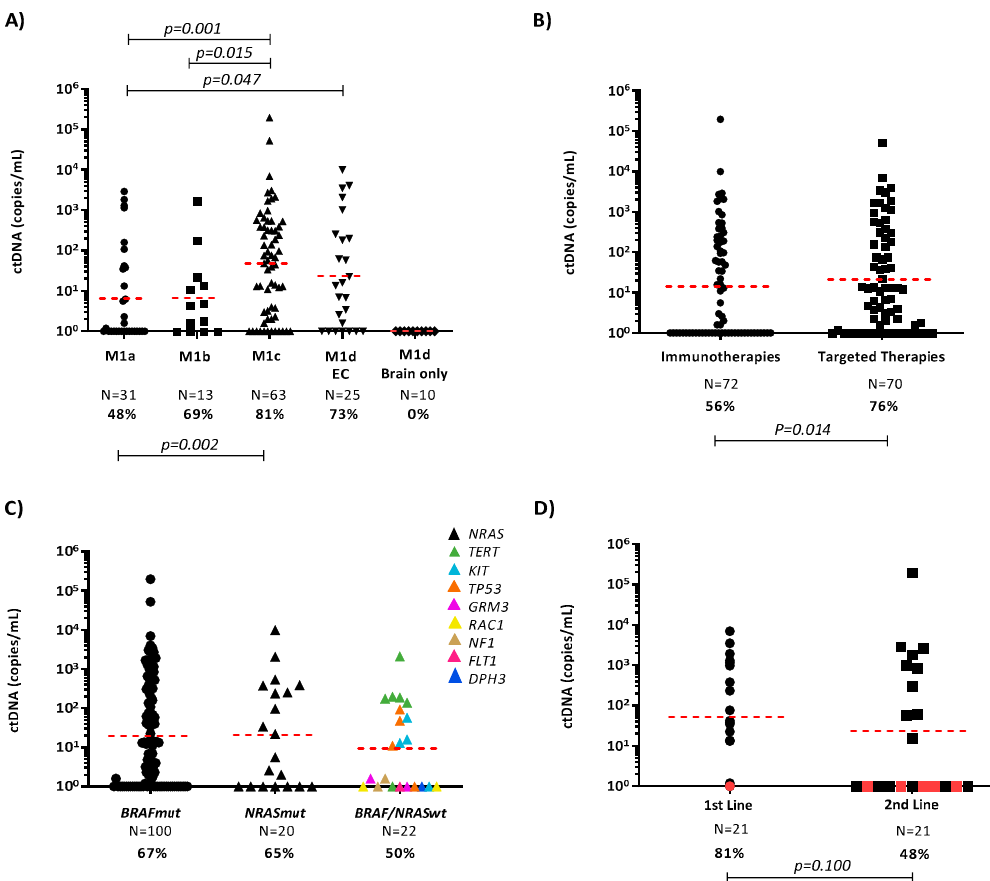
Figure 1. ctDNA quantification in melanoma patients prior to commencing systemic therapy. ( A ) Plasma ctDNA levels (copies/mL of plasma) in melanoma samples (N = 144), stratified by M status. M1d cases were further subdivided into those with extracranial (EC) and those with brain only metastases. Percentages denote the frequency of patients with detectable ctDNA. The geometric mean of ctDNA concentrations is indicated for each group by a dashed red line. Unpaired t-test P- values of the log-transformed ctDNA levels are indicated. ( B ) Dot plot diagram showing ctDNA at baseline in patients treated with immunotherapy (IT) and targeted therapy (TT). ( C ) ctDNA detection in patients with BRAF , NRAS or BRAF/NRAS wild-type tumours commencing first-line treatment. ( D ) ctDNA detection at first-line and second-line treatment in BRAF mutant patients. Red dots represent patients with intracranial disease only at the time of starting therapy.